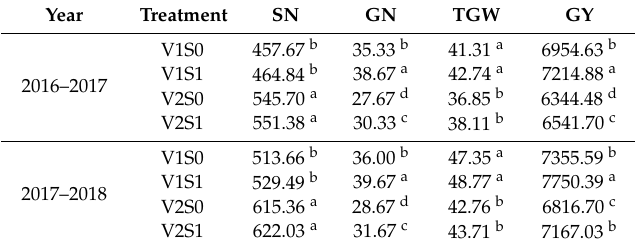
Table 2. Di ff erences of yield and yield components under exogenous 6-BA treatment and the control in wheat.